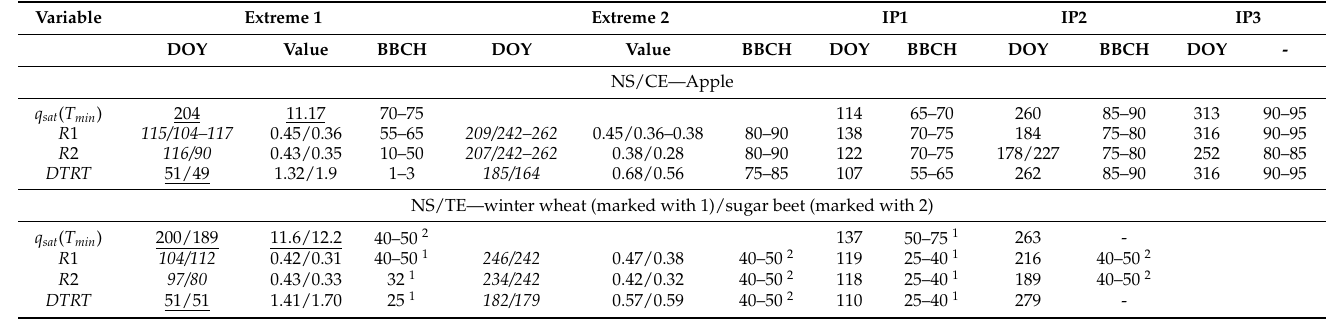
Table 3. Timing of extreme values and inflection points of q sat ( T min ), R 1, R 2 and DTRT in NS/CE orchard and NS/TE crop canopy (note the denotations used in all the following tables: (a) fitted value/measurement-based value; (b) italic—minimum; underline—maximum].